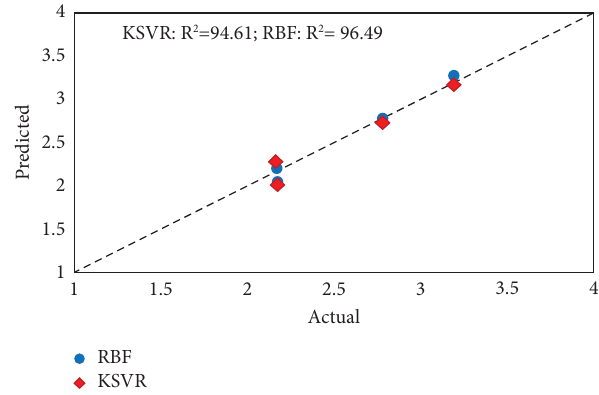
Figure 12: Actual and predicted values of ITS by the RBF and KSVR models for test data.